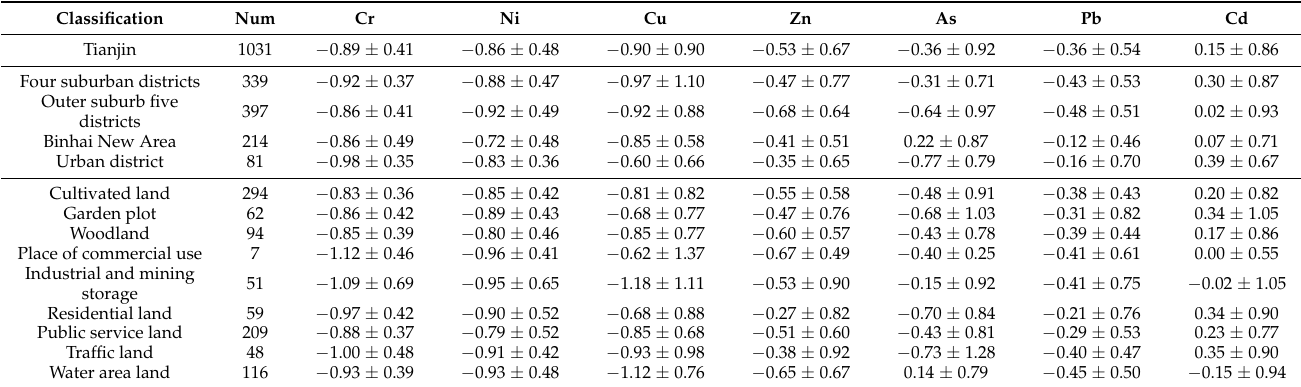
Table 3. Geoaccumulation index of heavy metals in soils of Tianjin.